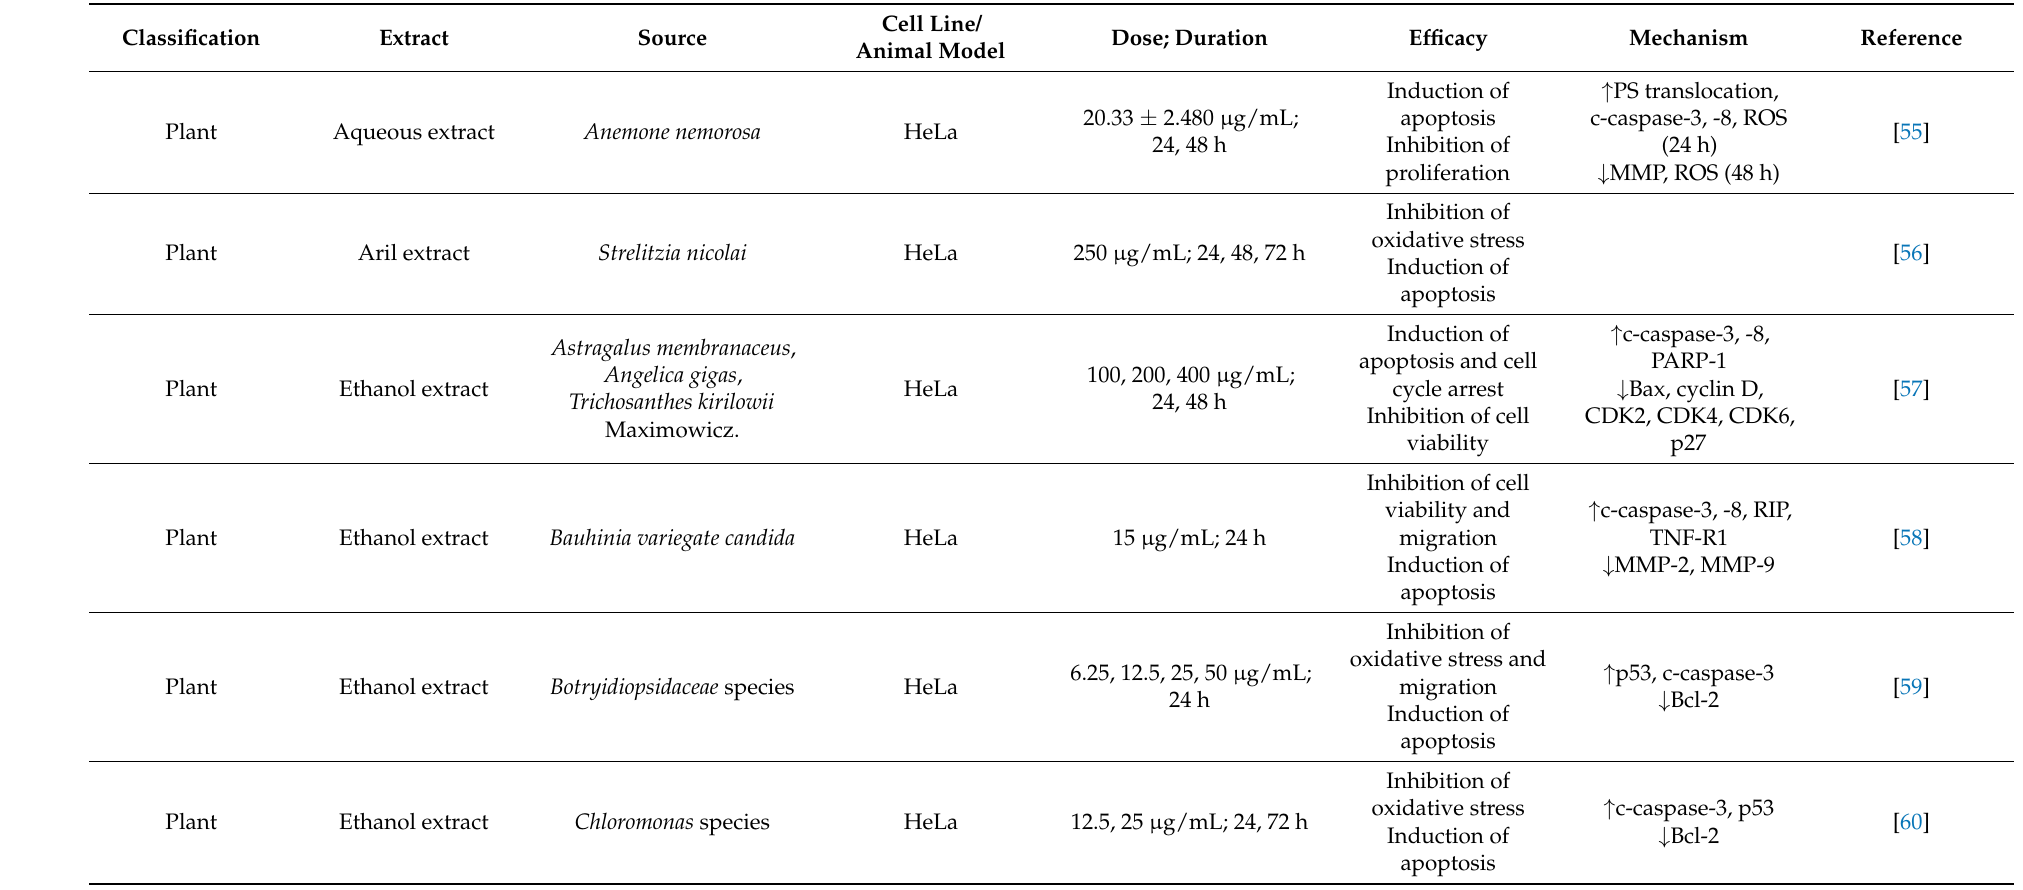
Table 2. Apoptosis inducing natural